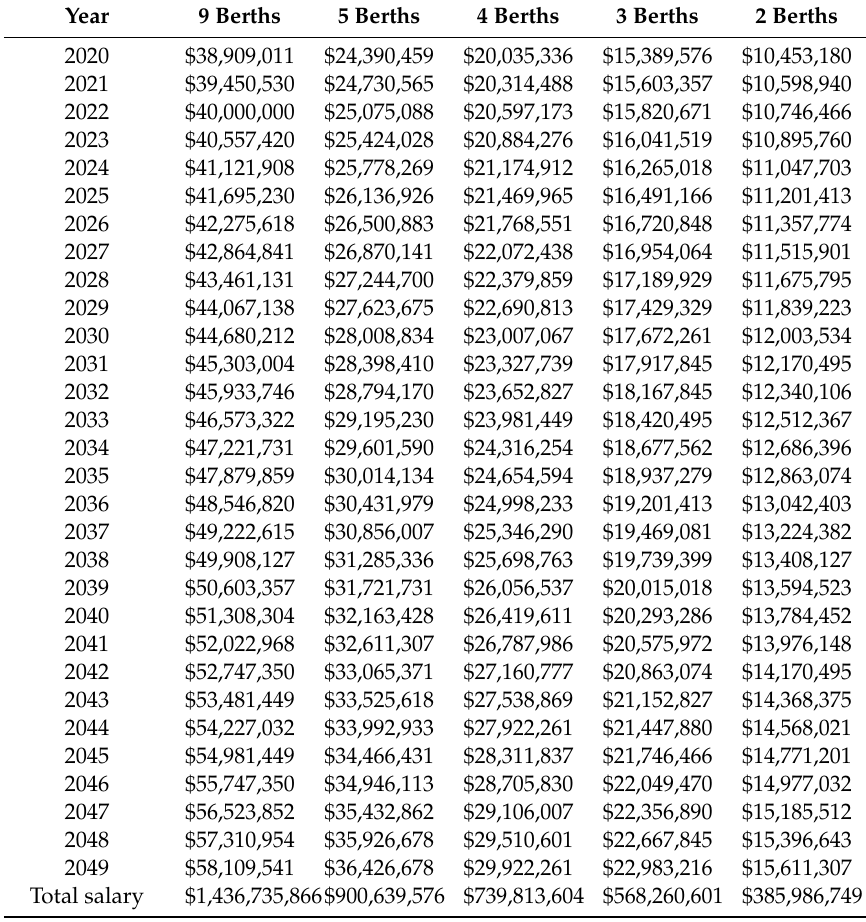
Table 6. Total labor costs (unit: U.S.